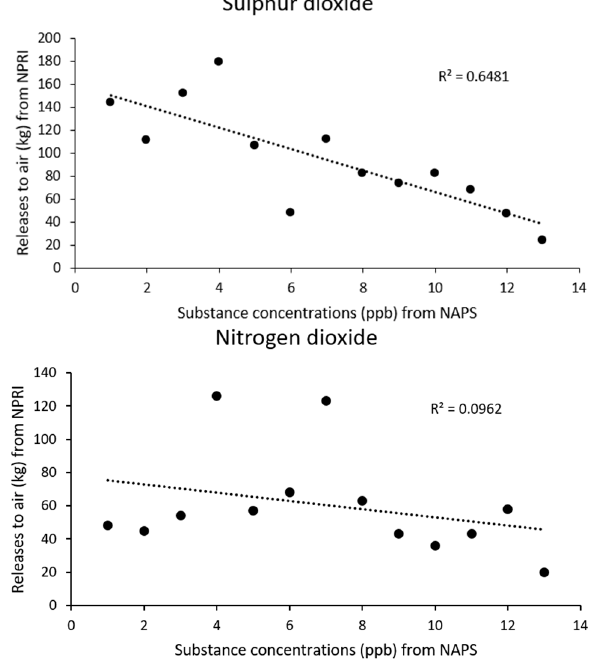
Figure 7. Comparison of NPRI and NAPS data for sulfur dioxide and nitrogen dioxide for an oil and gas facility from 2002 to 2015.